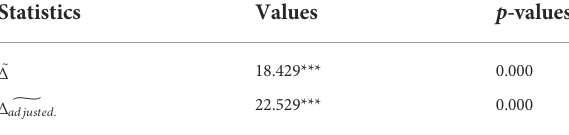
TABLE 3 The Slope homogeneity test.